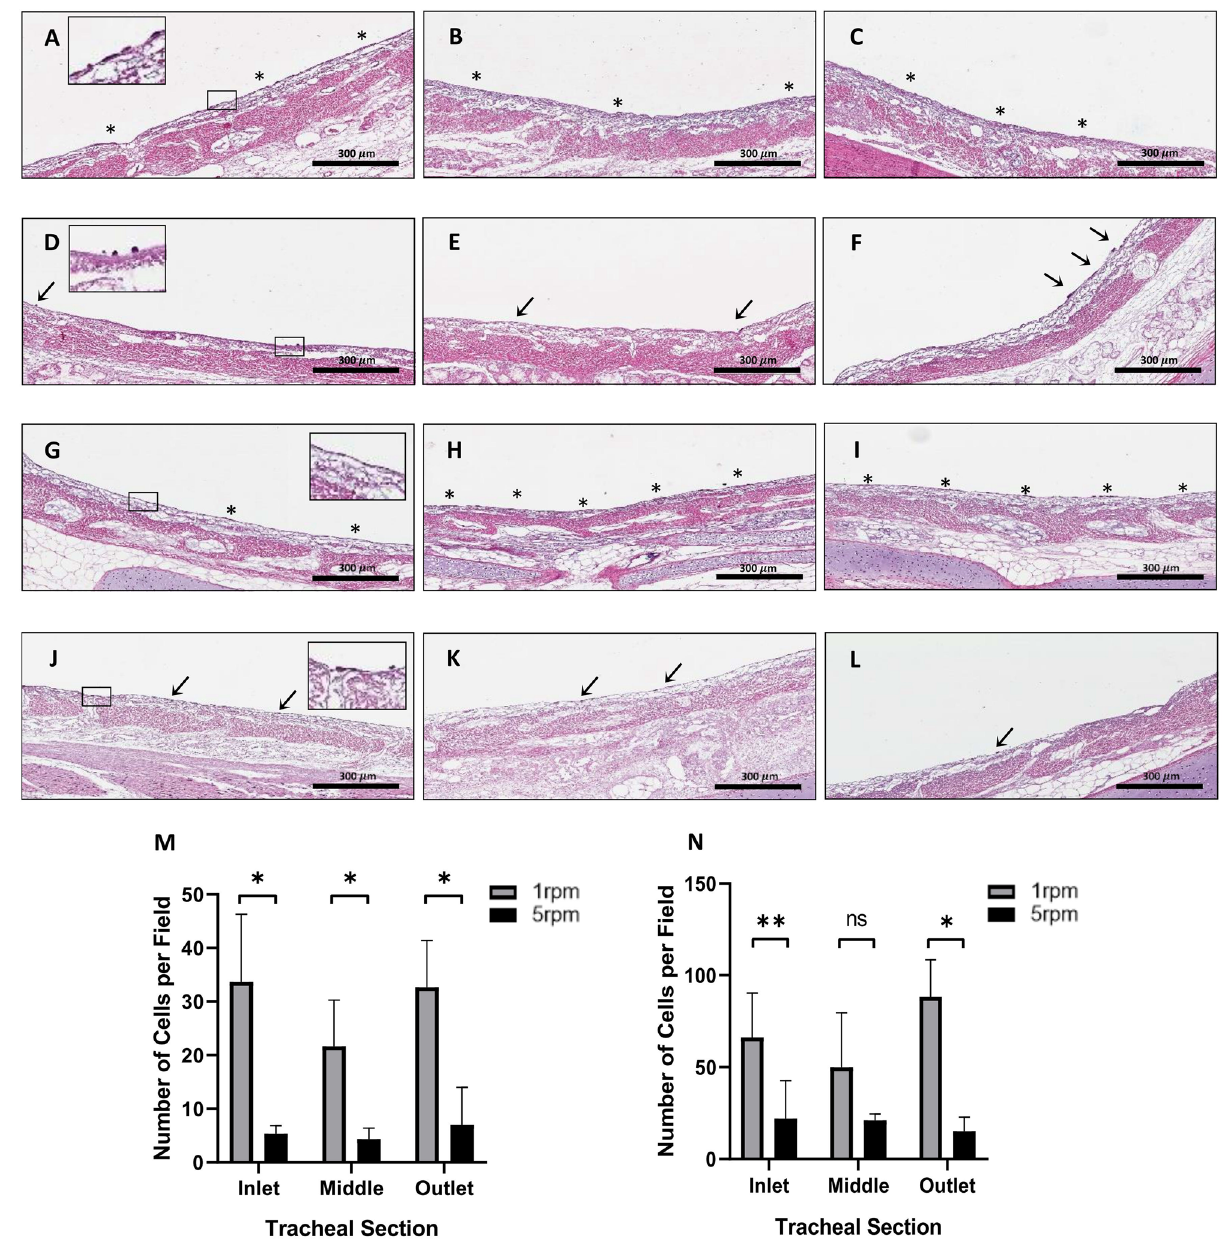
Figure 5. The H&E staining and cell quantification results comparing seeding at different rotational speeds in the single rotating inlet bioreactor. Inlet, middle, and outlet tracheal sections 2 h after seeding at ( A – C ) 1 rpm, and ( D – F ) 5 rpm; and 24 h after seeding at ( G – I ) 1 rpm, and ( J – L ) 5 rpm. Cell quantification results after ( M ) 2 h, and ( N ) 24 h in the bioreactor at 1 rpm (1.48e−04 Pa), and 5 rpm (4.11e-04 Pa). Data presented as means with standard deviations (n = 3 each group, ** p = 0.0024, * p < 0.02, ns = not significant with p >